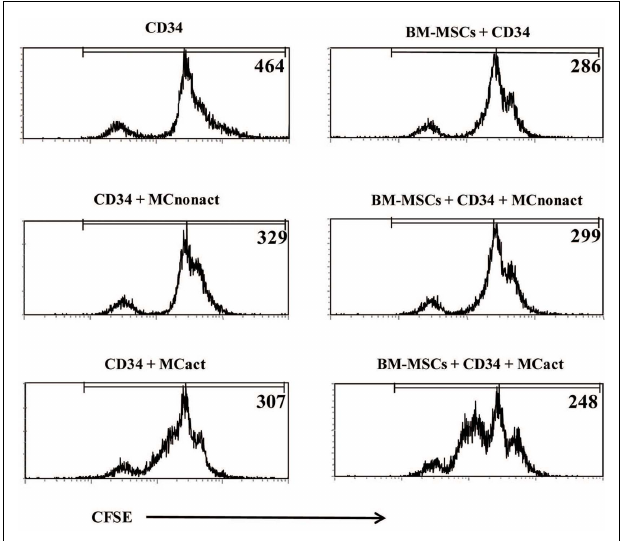
FIGURE 4 | Bone marrow-derived mesenchymal stromal cells preactivated with mast cells induce proliferation of CD34 + progenitor cells and regulate allergy-related genes in CD34 + progenitors . CFSE-labeled freshly isolated CD34 + progenitor cells were co-cultured for 3days with BM-MSCs exposed to activated in aTranswell system mast cells (kept in cultures for 6h while cross-linking with anti-IgE and then removed) and their proliferation was assessed. Numbers refer to mean fluorescence intensity (MFI) of CFSE-labeled CD34 + -gated cells. Representative of three experiments.